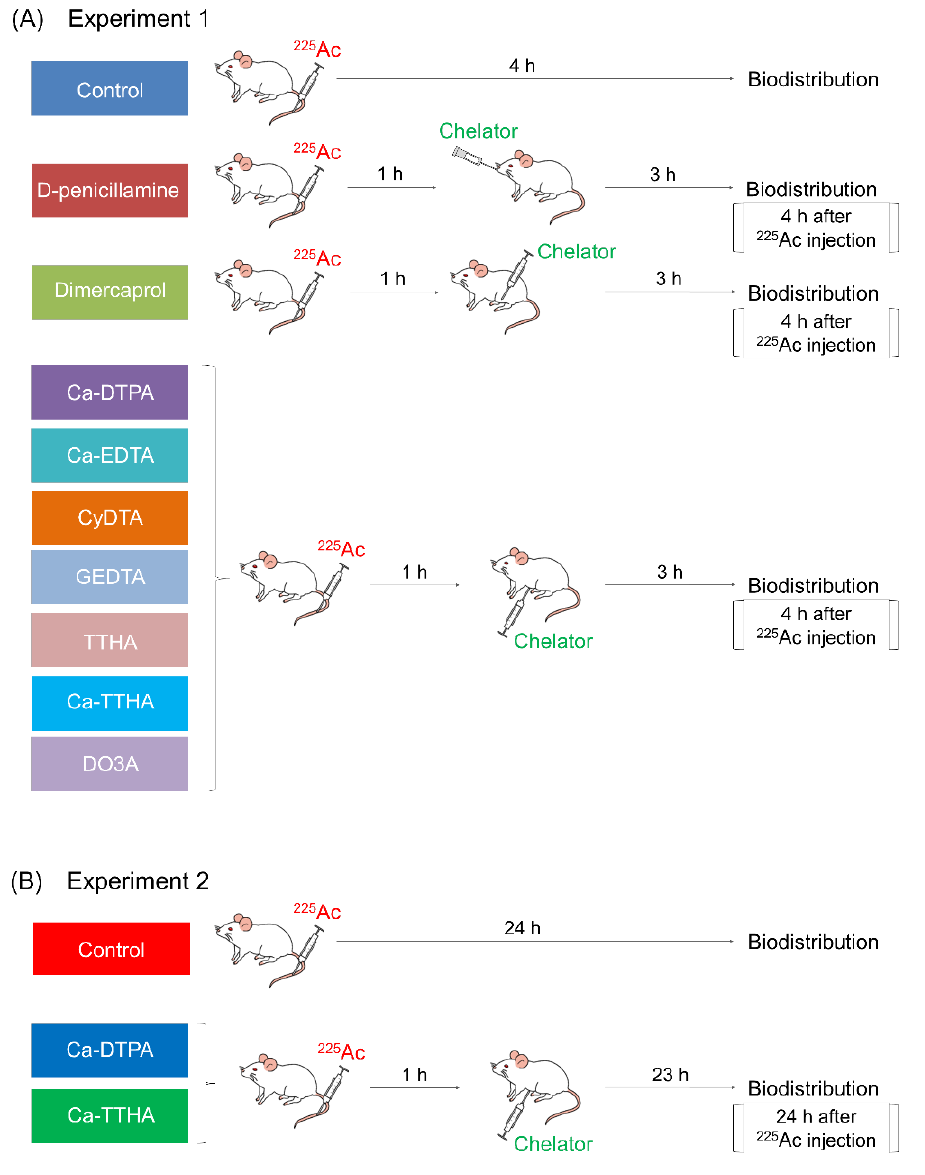
Figure 2. Schedule of the in vivo chelating study. Biodistribution studies of free 225 Ac with chelators as conducted in Experiments 1 ( A ) and 2 ( B ).